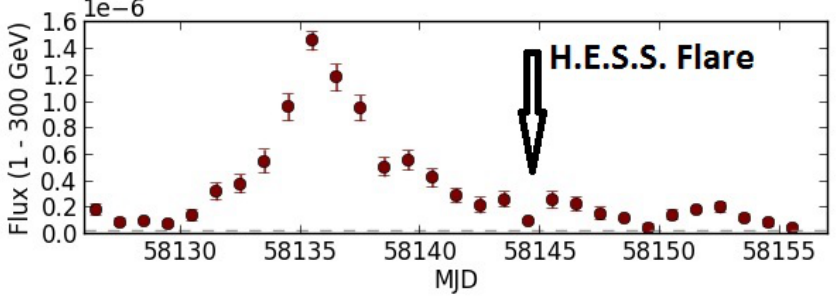
Figure 2. Fermi -LAT GeV γ -ray light curve of 3C 279 around the flare of January 2018. The heavy arrow marks the night of the H.E.S.S. VHE flare detection